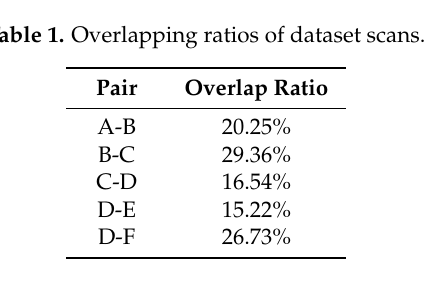
Table 2. Size of point-clouds.